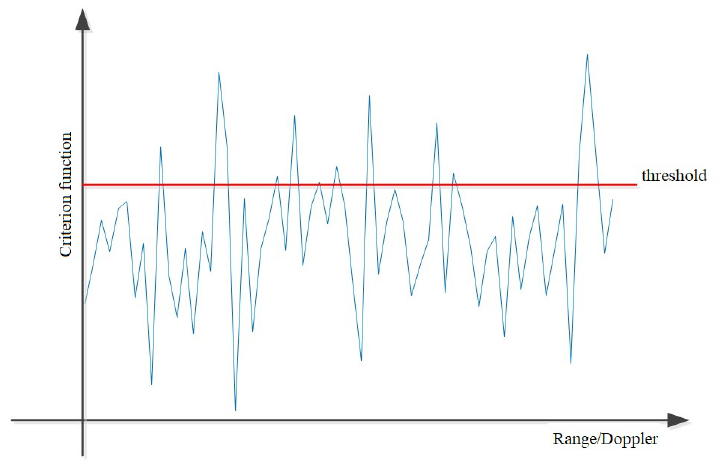
Figure 7. Detection procedure using